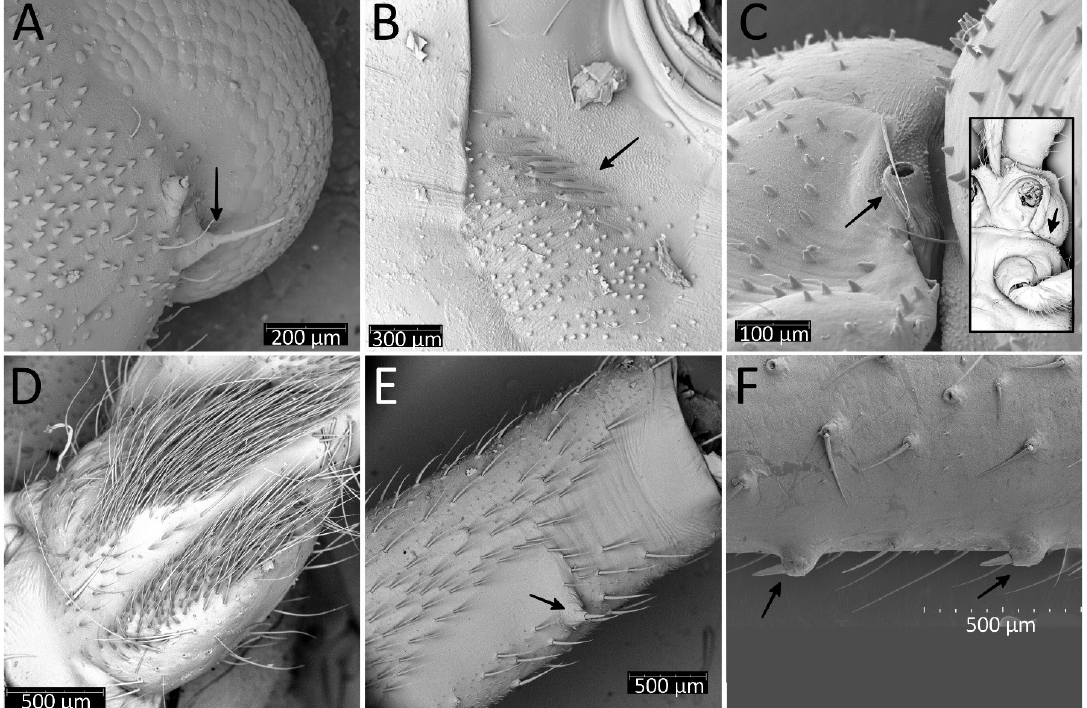
Figure 25. Psyttala horrida (Stål, 1865), fourth instar, SEM views. ( A ) An appendage near the eye on the ventral side; ( B ) pointed appendages visible under the forecoxa; ( C ) a spiracle-like structure at the lateral edge of the propleuron, visible only in the first and second instar; ( D ) two stripes with dense, long setae on the middle trochanter, ventral view; ( E ) an appendage on the distal part of the middle femur, ventral view; ( F ) appendages on the middle part of the hind femur, lateral